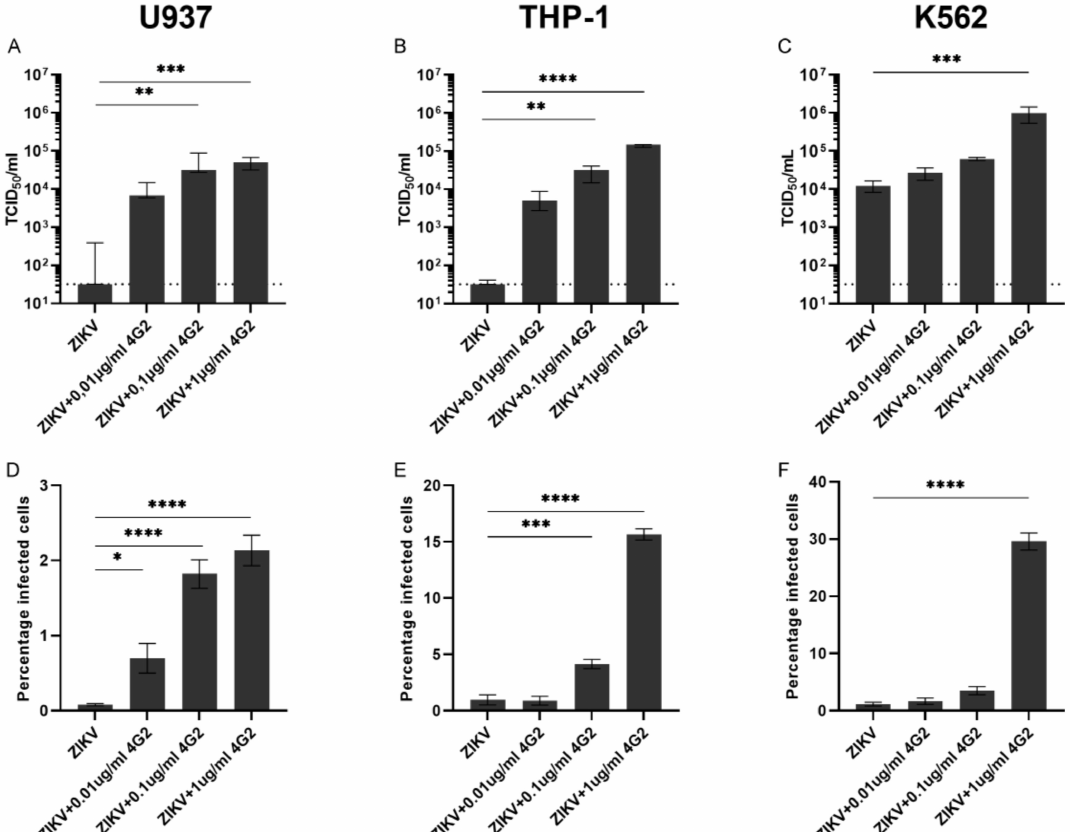
Figure 2. ADE of ZIKV infection in U937, THP-1, and K562 cells. Cells were infected for 48 h with ZIKV at an MOI of 0.5 with and without increasing concentrations of the pan-flavivirus humanized monoclonal antibody 4G2 (hu4G2). ZIKV titers were determined in supernatants ( A – C ) and the percentage of infected cells was determined with flow cytometry ( D – F ). Bars represent median titer ± IQR ( A – C ) and mean percentage of infected cells ± SEM ( D – F ). Statistical significance was determined with the Kruskal–Wallis test with Dunn’s post hoc test or a one-way ANOVA with Dunnett’s post hoc test, comparing the conditions with hu4G2 to infection with only ZIKV. * p < 0.05, ** p < 0.01, *** p < 0.001, **** p <